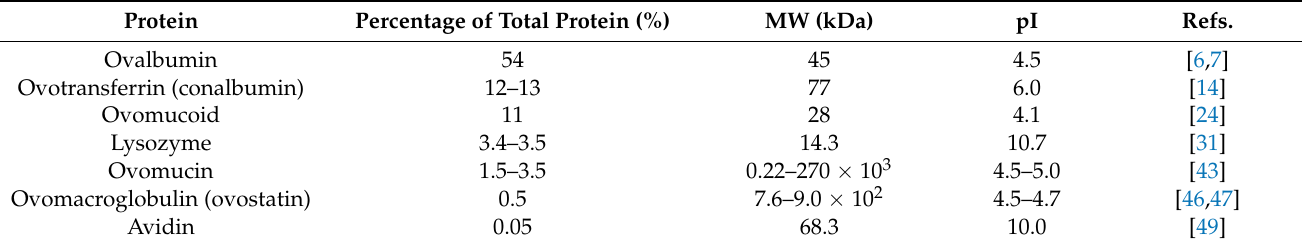
Table 1. Percentage of total protein, MW and pI of major egg